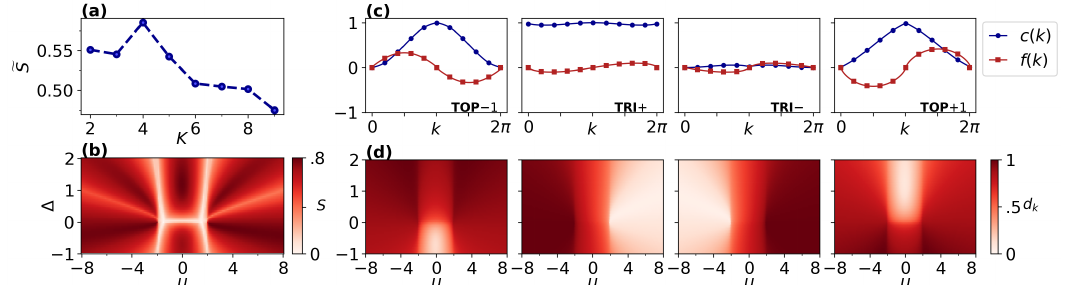
Figure 4: Non-interacting Hamiltonian: k-means clustering. (a) Values of the sil- houette score (cid:101) S as a function of the number of clusters K . The maximum value is reached at K = 4 and suggests the best number of centroids for the dataset points. (b) Reconstructed phase diagram of the non-interacting model (with K = 4 centroids) through the average silhouette S of every data point. The critical lines are clearly visible because the correlation functions of critical points have similar distances be- tween two centroids. (c) Centroids obtained by applying k-means algorithm with K = 4. Every centroid resembles the correlation functions of the four different re- gions: topological with ν = − 1, the two trivial phases with ν = 0 and topological with ν = + 1, from left to right. (d) Distances d of the correlation functions for k each point of the phase diagram from the corresponding k -th centroid (plotted in the corresponding panel above). The points belonging to the same phase show minimal distance to the same